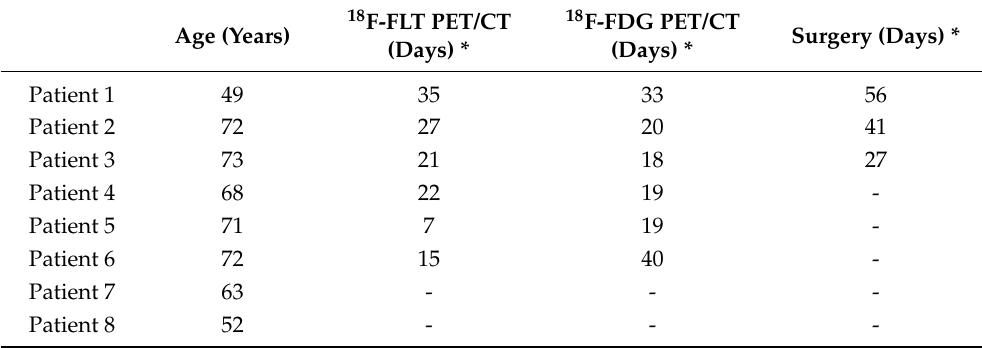
Table 1. Ages of treatment-naive patients before positron emission tomography/computed tomogra- phy and time series of each examination. 18 F-FDG PET/CT 18 F-FLT PET/CT Age (Years) (Days) *